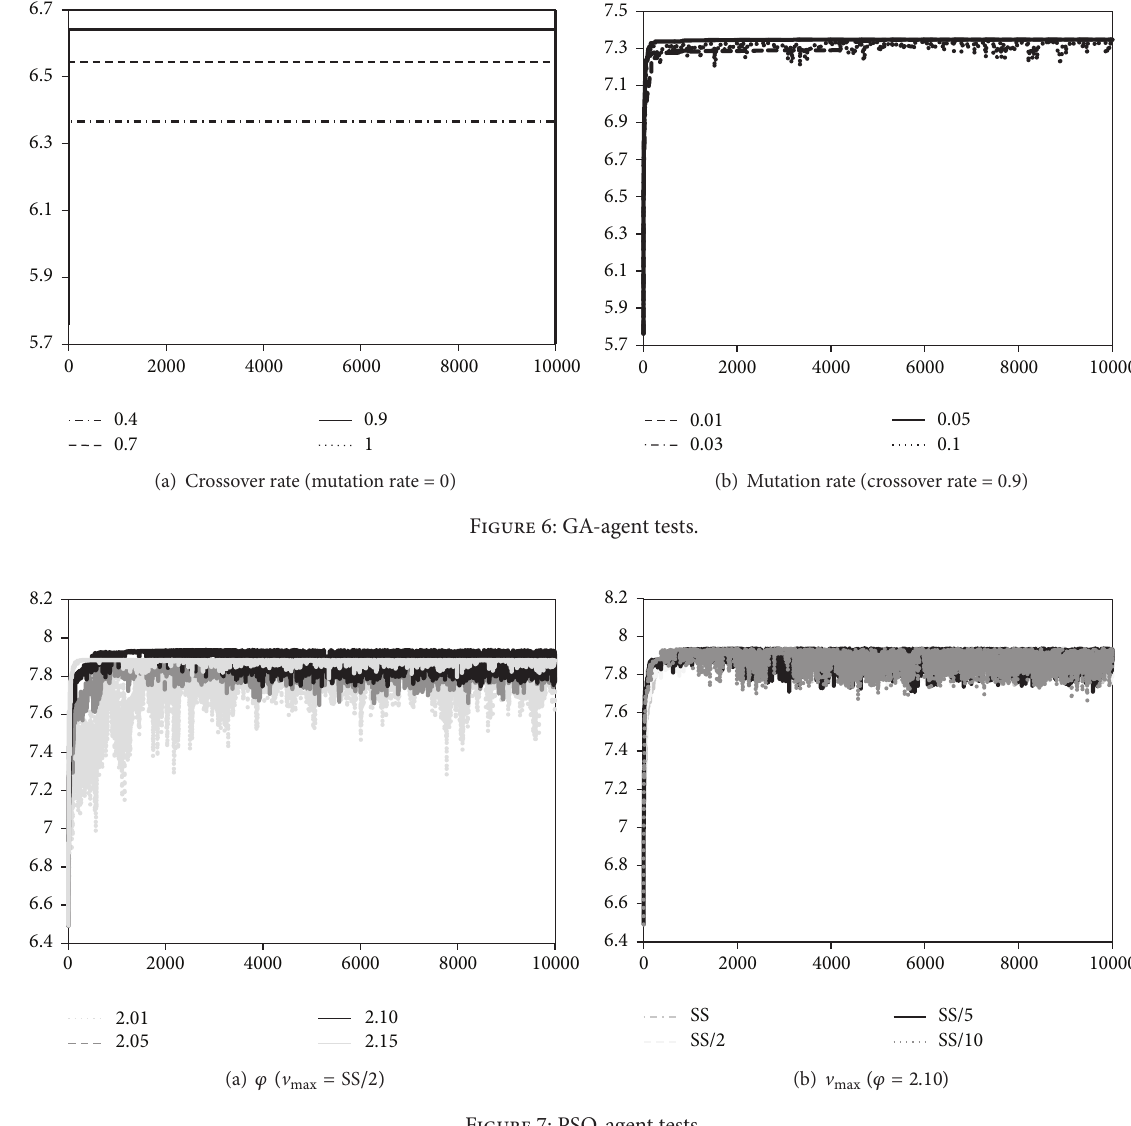
Figure 7: PSO-agent